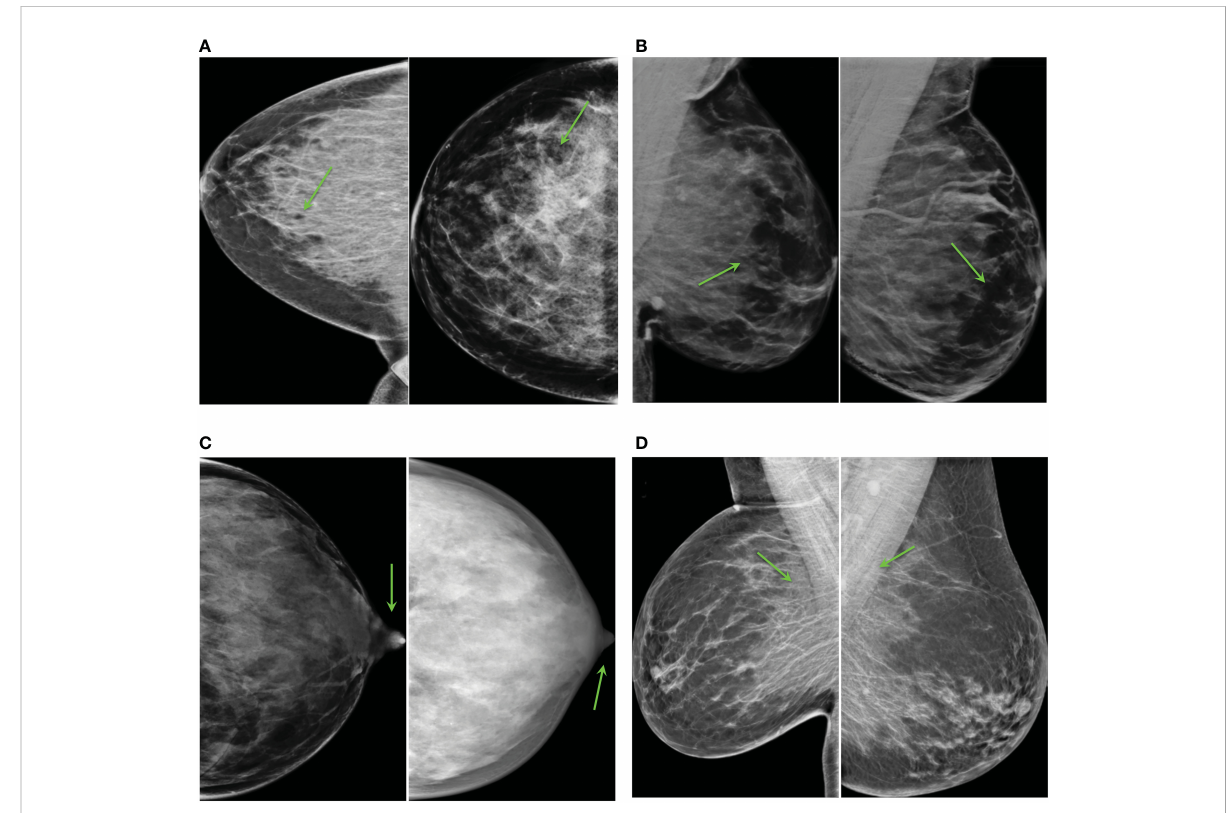
FIGURE 8 Common artifacts of synthetic high-density mammograms, (A) dark dots or ovals, (B) lack of glandular tissue behind the nipple, (C) distorted nipples, (D) big concentrations of glandular tissue adjacent to the pectoral